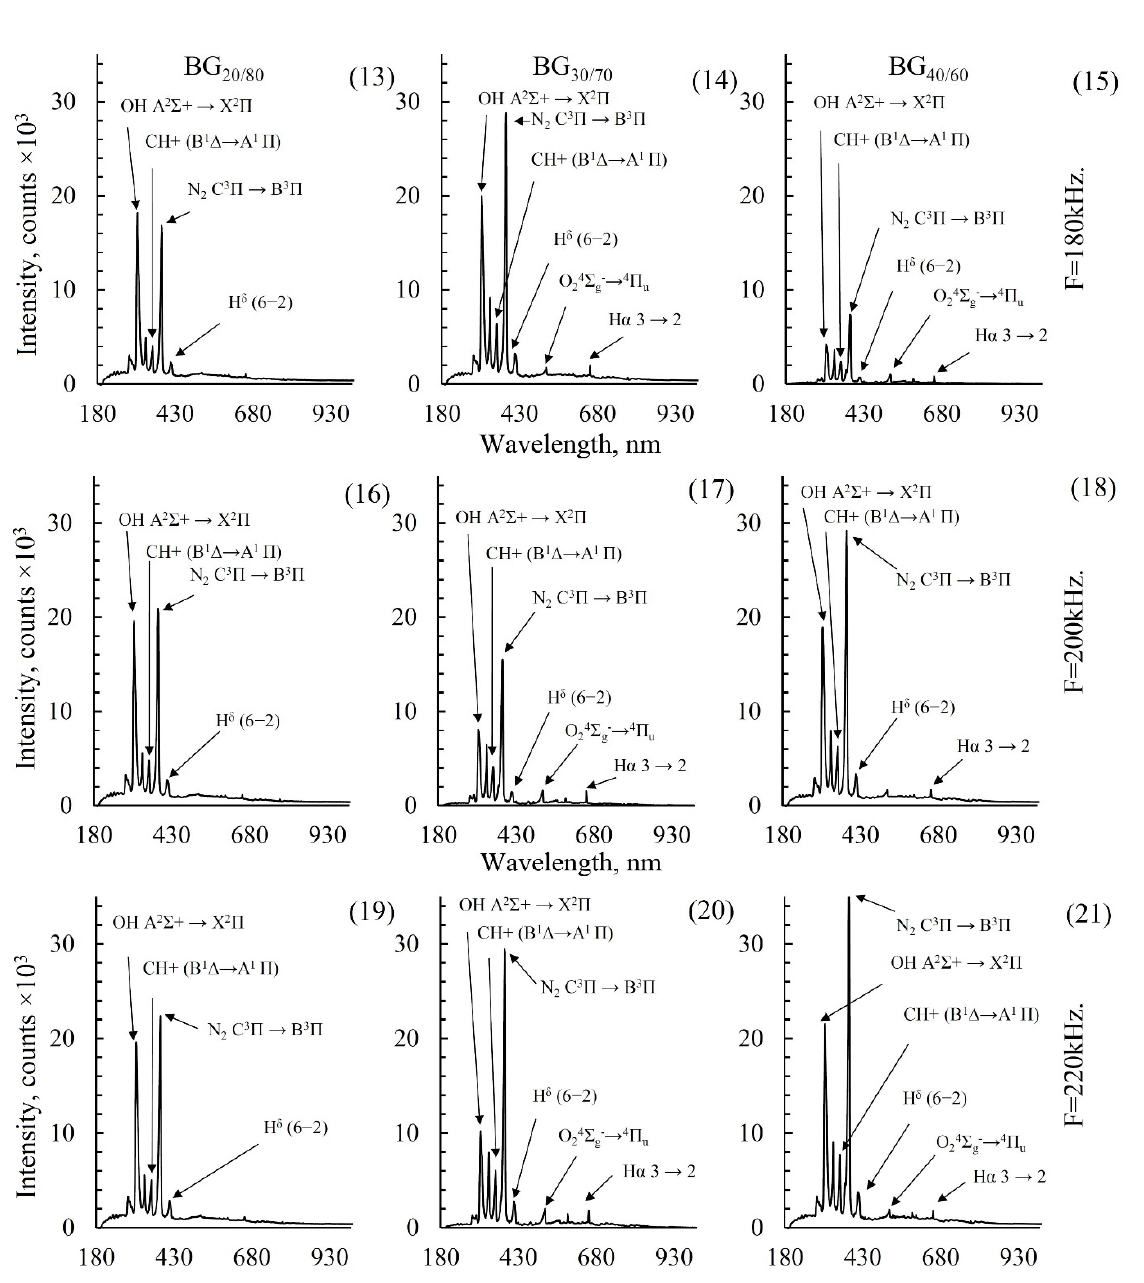
Figure 6. Emission spectrometry of biogas. U = 8300 V, F = 180–220